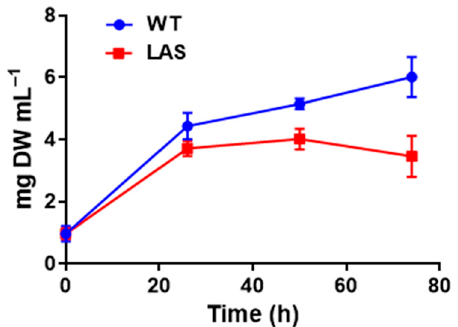
Figure 4. Growth of WT (in blue) and LAS (in red) in medium containing C16:0 as carbon source. Each value is the mean of three biological replicates, and error bars indicate the standard deviation. Graphs and statistics were performed with GraphPad Prism ® software.